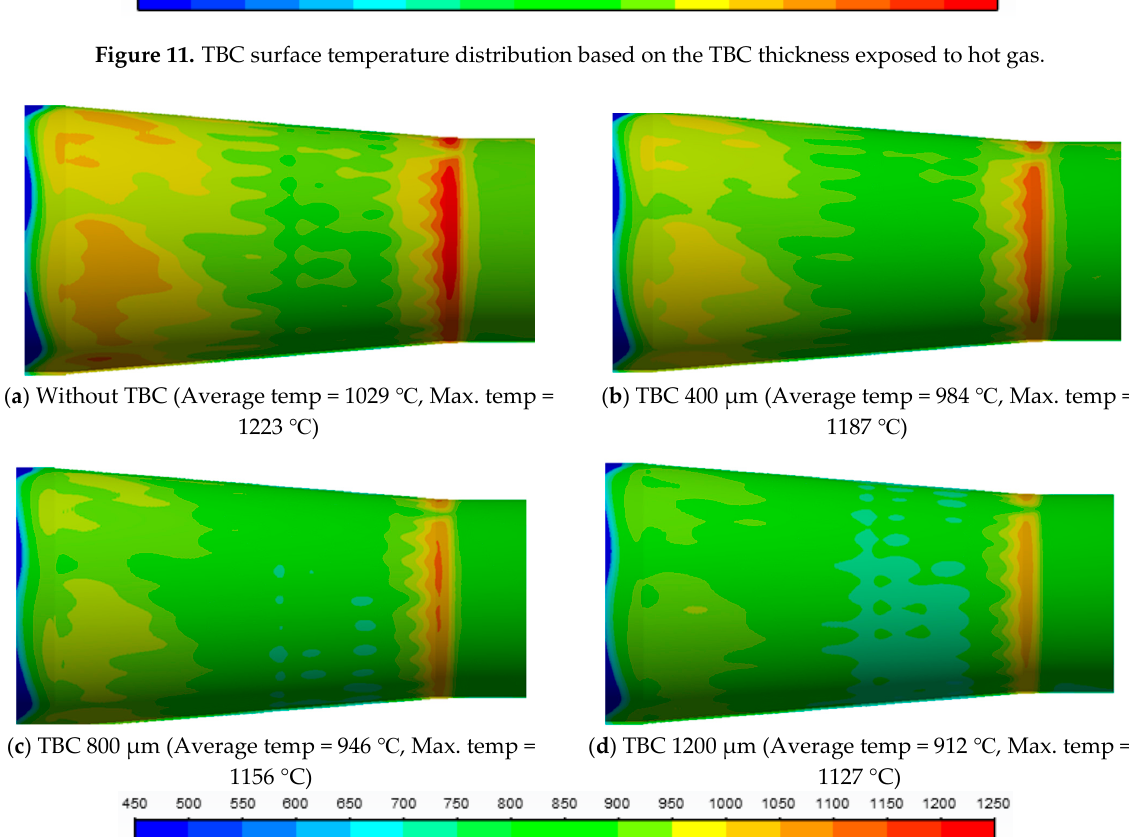
Figure 12. Inner CL metal surface temperature distribution (combustion side) based on the TBC thickness. The TBC thickness can have an effect on the outer wall of the CL in the cooling side. Figure 13 shows the wall temperature distribution of the outer metal surface based on the TBC thickness. The average and maximum wall temperature were reduced by increasing the TBC thickness. The TBC effectively reduced the higher temperature hotspots in the forward shell section, resulting in a uniformity result, as shown in Figure 13d.